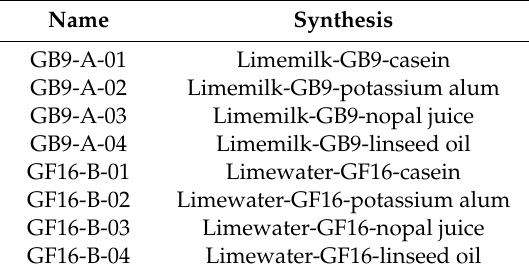
Table 12. The colour synthesis with natural